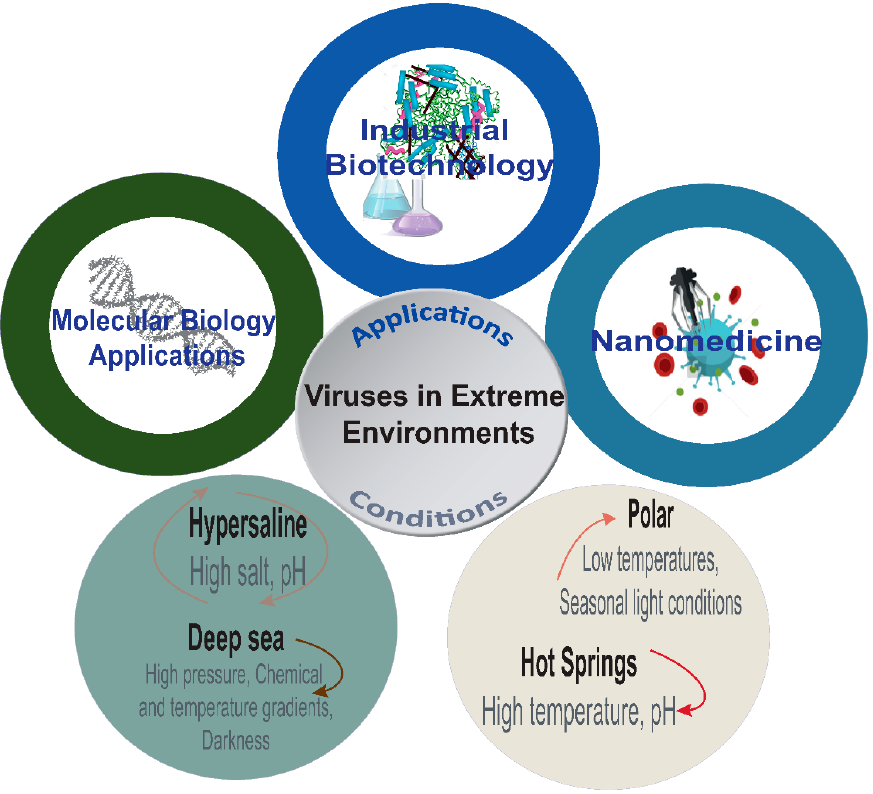
Figure 1. Main features of the extreme conditions and potential applications of extremophile viruses. Physical and chem- ical characteristics modeling the different environments and the potential biotechnological applications of viruses includ- ing molecular biology applications, nano-medicine and drug delivery and industrial